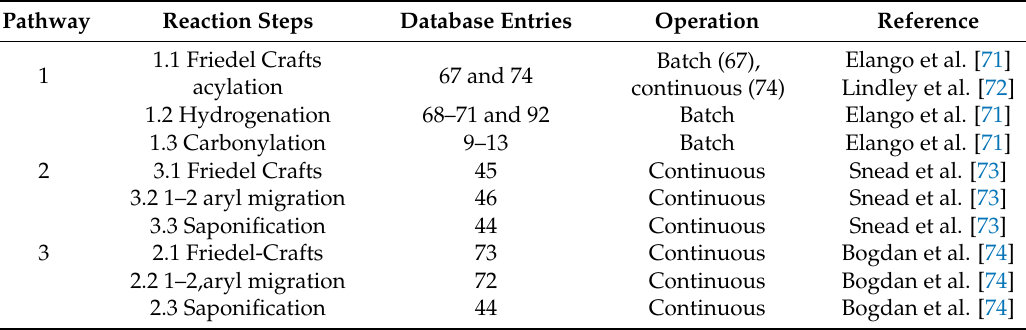
Table 11. Summary of the data retrieved from the